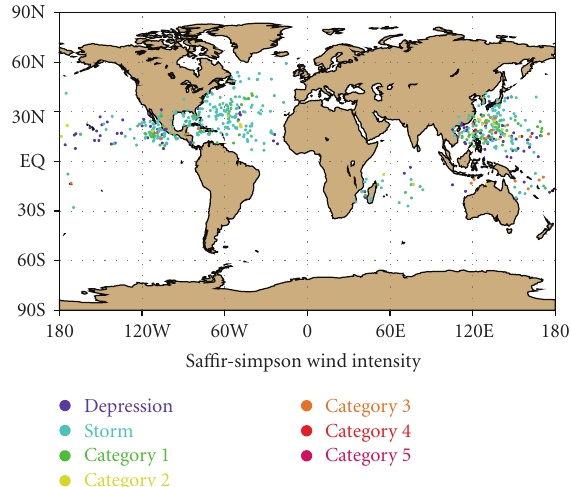
Figure 2: Histogram of GPS RO observations collected within depression (purple), tropical storm (cyan), hurricane (red), and all TC (black) environments as a function of radial distance. Radial distance interval is 50 km.